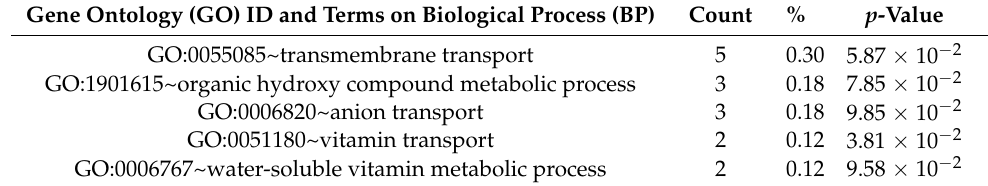
Table 3. The functional analysis of the upregulated genes at 3 h after LLL